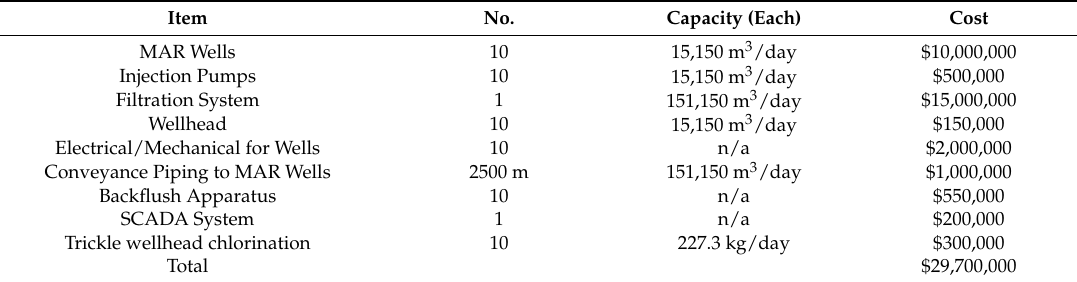
Table 1. Breakdown of Capital Costs for the Proposed MAR System.